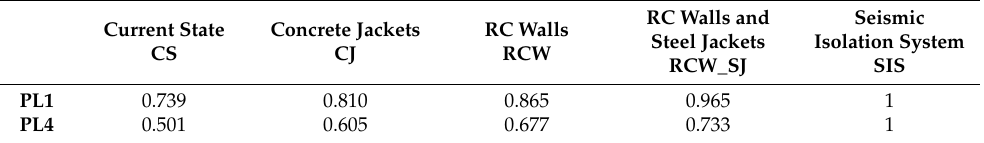
Table 2. Effects of different retrofitting techniques: resilience index for PL1 and